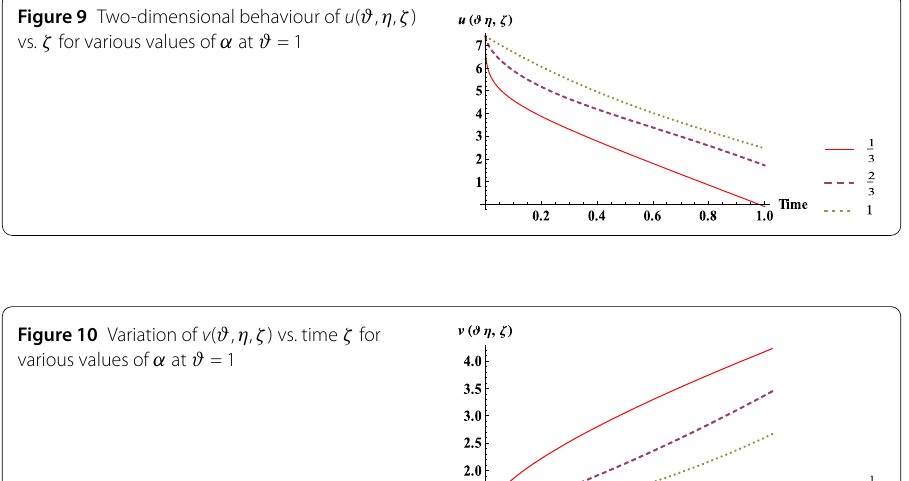
Figure 11 Variation of w ( ϑ , η , ζ ) vs. time ζ for various values of α at ϑ = 1